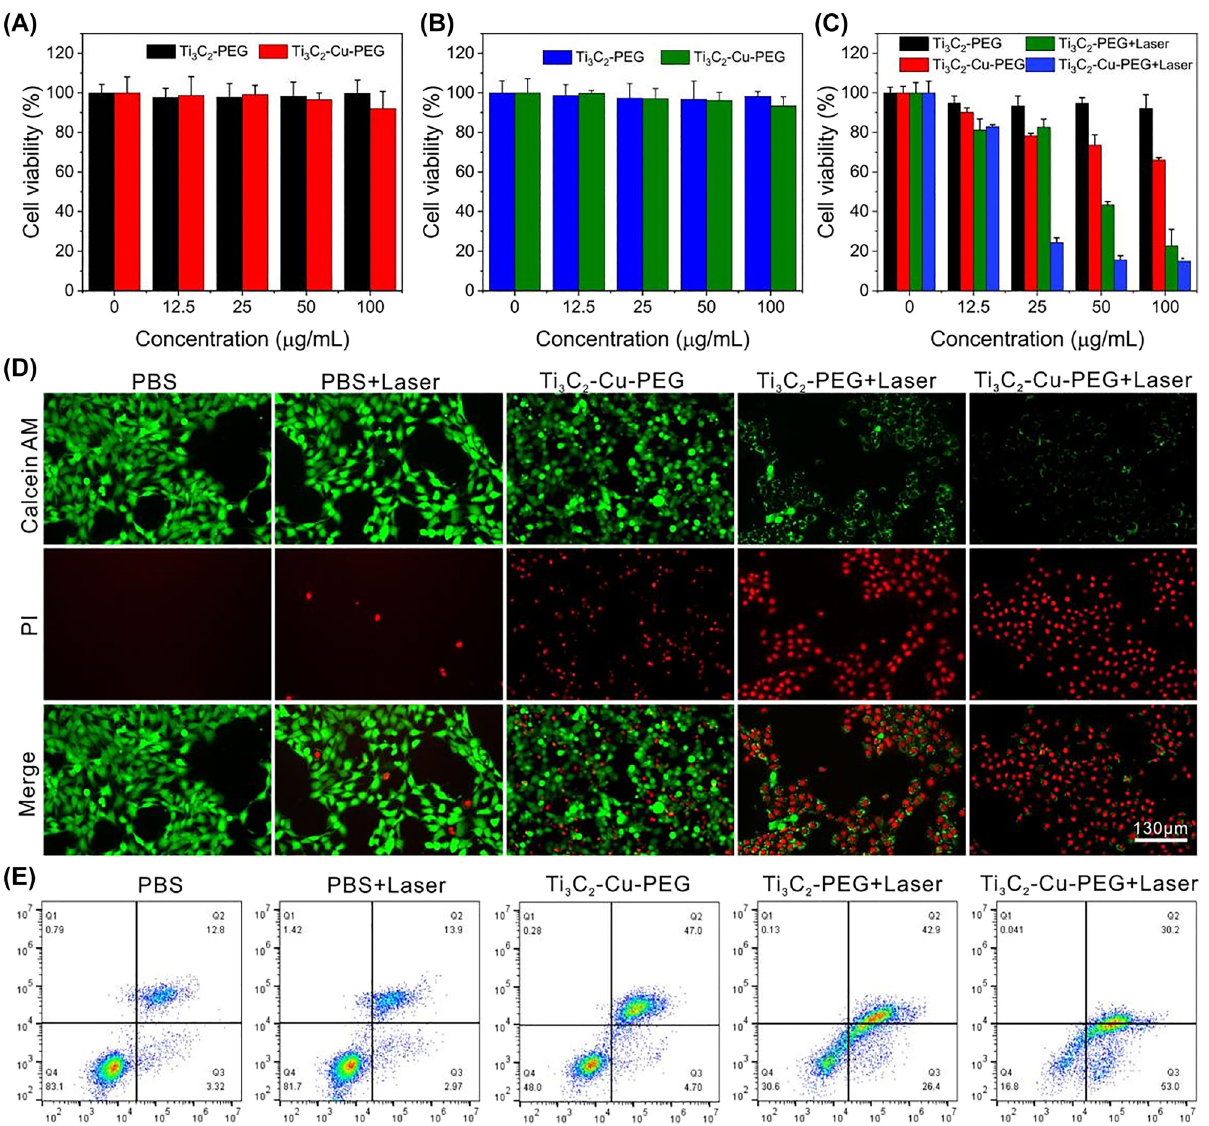
Figure 5: In vitro evaluation of the cytotoxicity for cancer cells under NIR irradiation. Relative cell viabilities of HUVEC cells (A), and NIH3T3 C -PEG and Ti C -Cu-PEG at diverse concentrations (0, 12.5, 25, 50, 100 μ g/mL). (C) Cytotoxicity profiles of 4T1 cells (B) incubated with Ti 3 2 3 2 cells after being treated with different formulations. (D) Calcein-AM/PI staining and, (E) flow cytometry analysis of cell apoptosis of 4T1 cells incubated with different